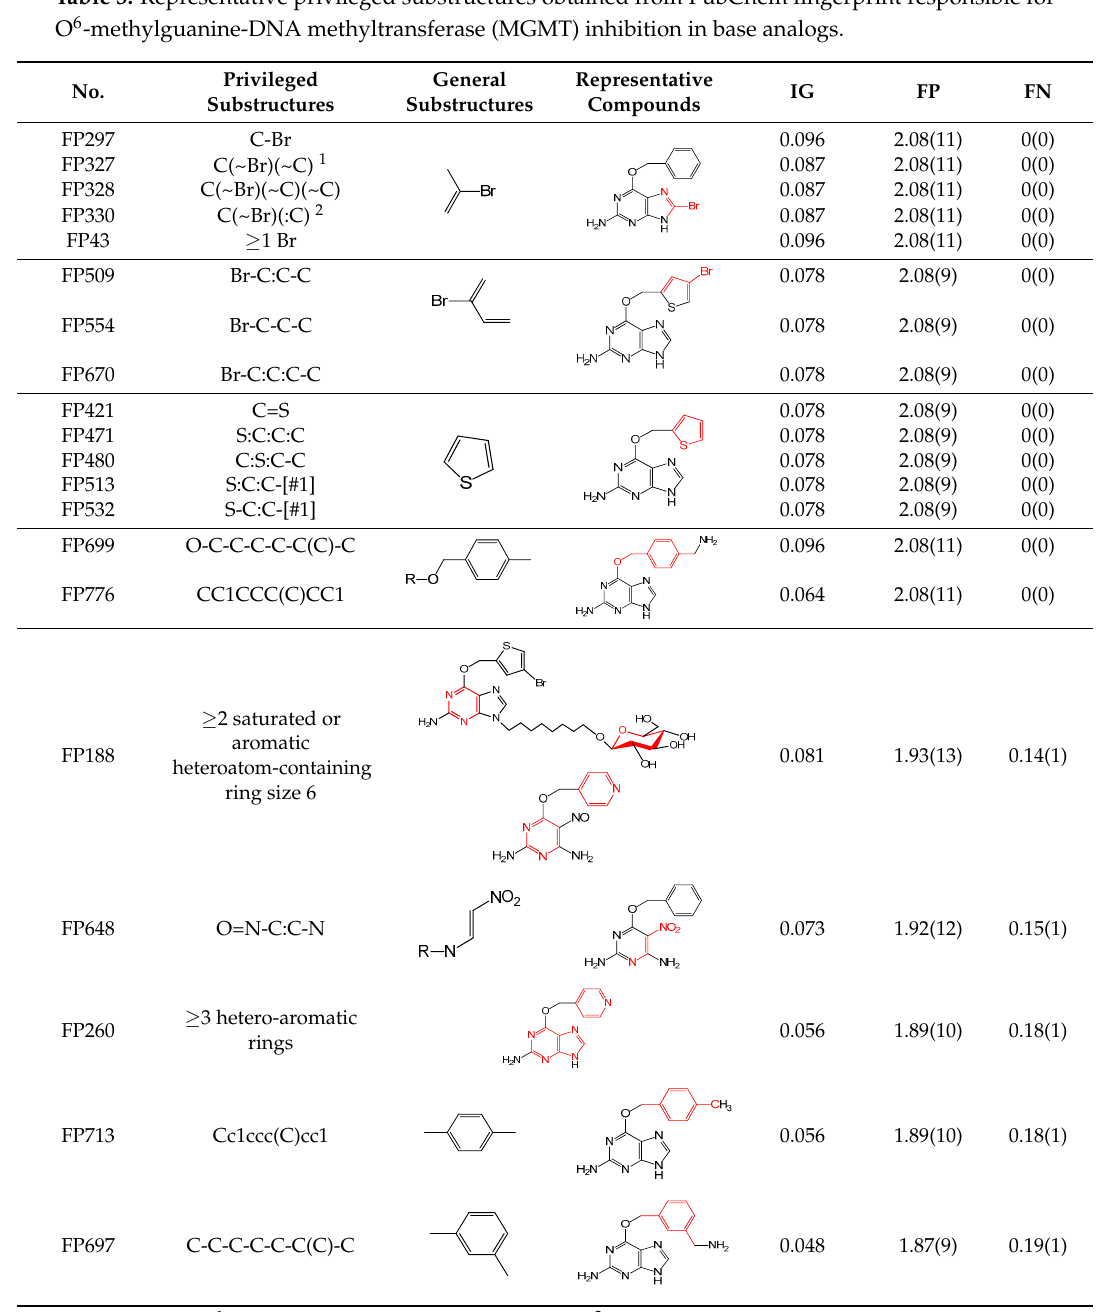
1 “~“represent “regardless of bond order”; 2 “:” represents bond aromaticity.